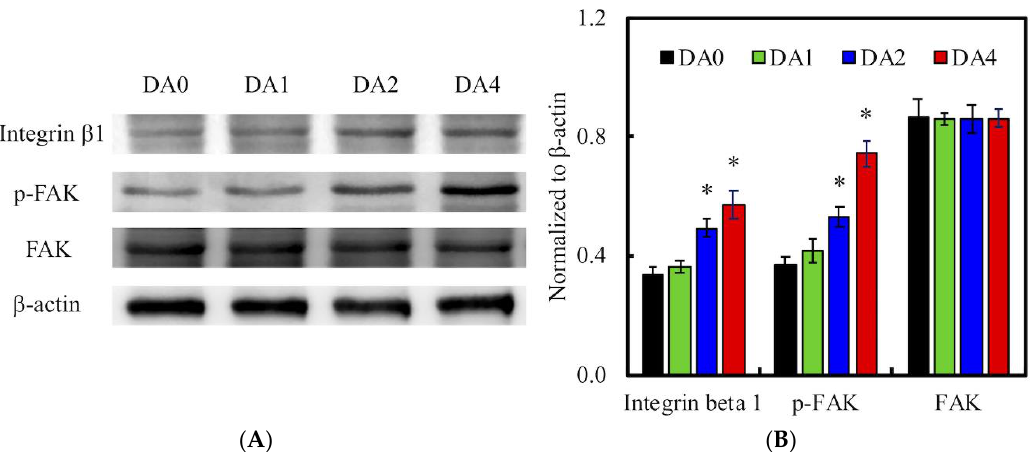
Figure 8. ( A ) Integrin β 1 and pFAK expression of WJMSC cultured on various samples after 3 h of incubation; ( B ) The values for the proteins levels were normalized to the actin levels. “*” indicates a significant difference ( p < 0.05) compared to DA0.